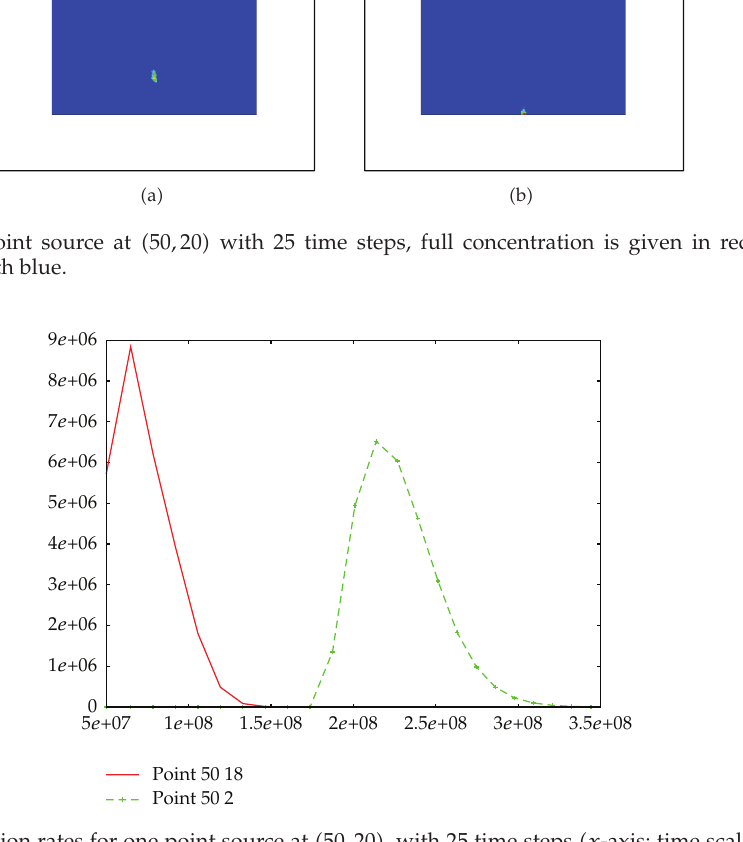
Figure 9: Deposition rates for one point source at (cid:2) 50 , 20 (cid:3) , with 25 time steps (cid:2) x -axis: time scale in (cid:2) nsec (cid:3) , y -axis: deposition rate in (cid:2) mol/nsec (cid:3)(cid:3)